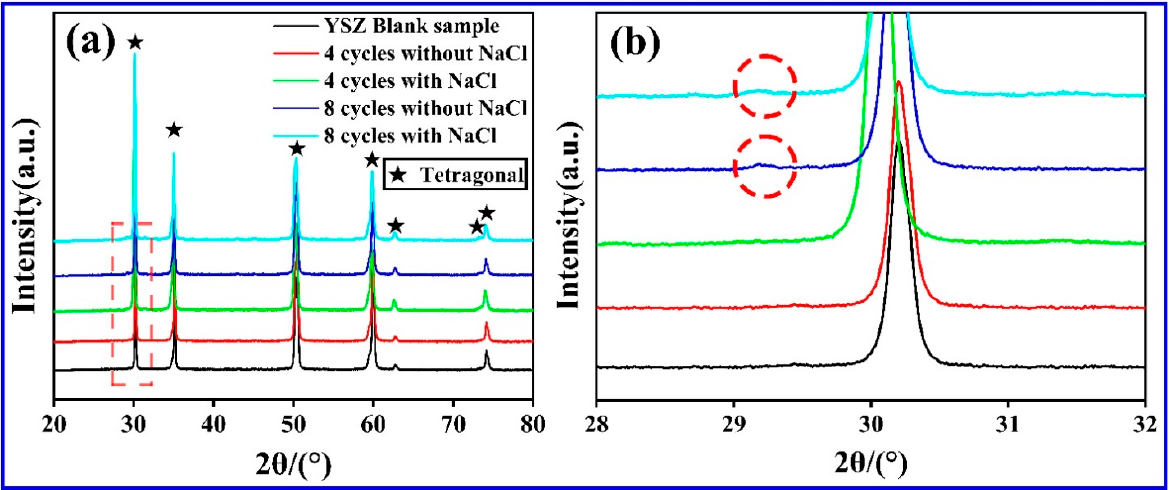
Figure 7. ( a ) X-ray diffraction pattern of YSZ samples at different corrosion stages and ( b ) a par- tially enlarged diagram from 28° to 32°.